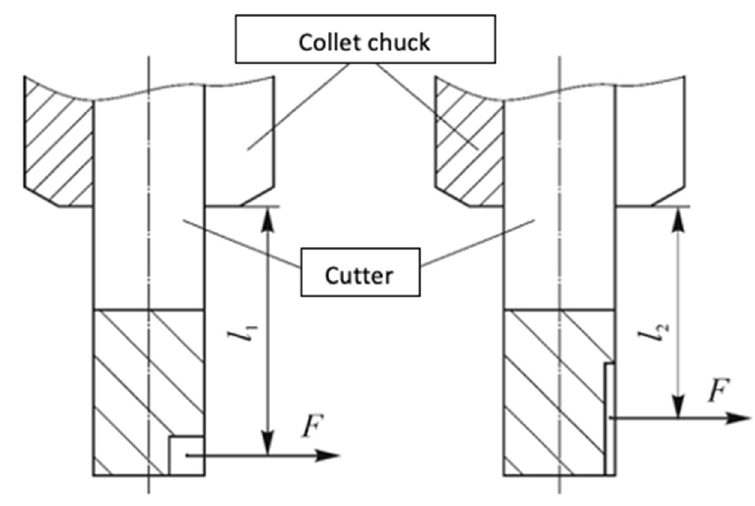
Figure 15. Point force application diagram for different of milling depth to width ratios.